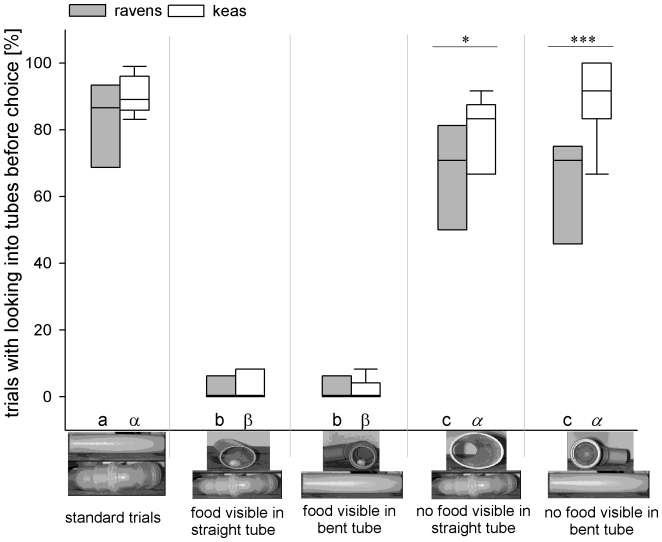
Percentage of trials in which birds inspected at least one tube before making a choice.Box plots show median and upper and lower quartile. Whiskers indicate 10%- and 90% - confidence interval. Pictures below x-axis show the condition-specific tube arrangement. Between-species differences within conditions are indicated by asterisks (post-hoc Holm-Sidak analysis). Within-species differences between conditions are indicated by different letters below the bars. Roman letters (a,b,c) refer to comparisons within ravens and greek letters (α, β, γ) refer to comparisons within keas. Bars marked with different letters differ significantly from another (post-hoc Holm-Sidak analysis), letters printed in italics indicate a trend to differ from bars marked with normally printed letters.